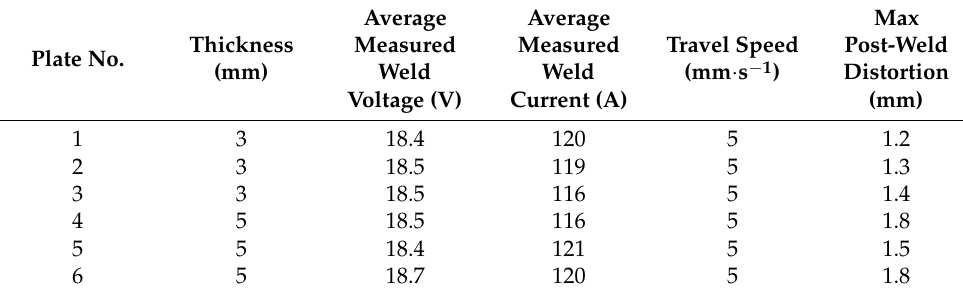
Figure 2. Diagram of deformation position measurement. Table 3. Process parameters and post-weld distortion data.